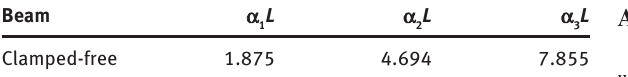
Table 1 Non-dimensional frequency parameters ( β ) of cantilever beam.